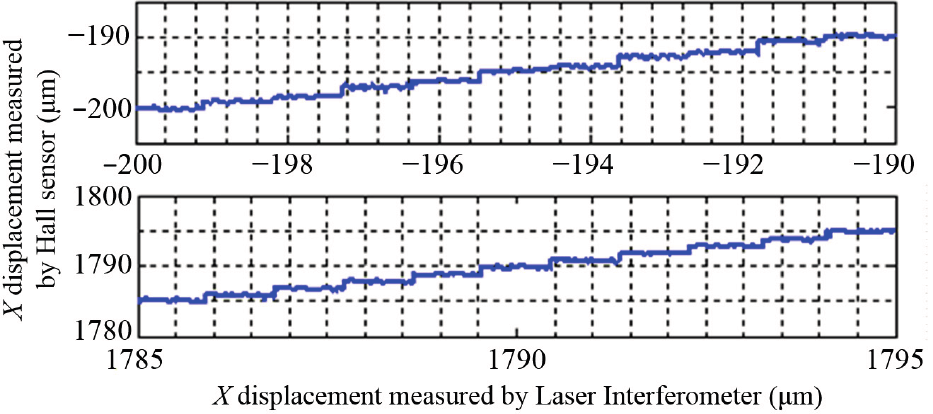
Figure 15. The resolution of the Hall sensors in X